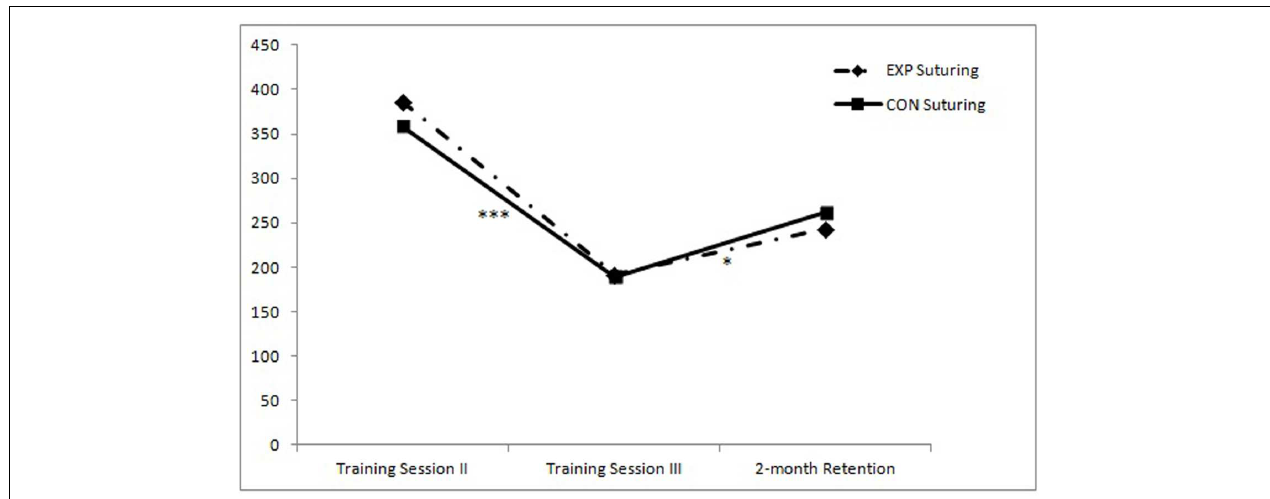
FIGURE 2 | Median completion times (in seconds) for the advanced laparoscopic task at the end of the second and third training session, and at retention for both training groups (Within-subject progress: ∗ p < 0.05; ∗∗ p < 0.01; ∗∗∗ p <